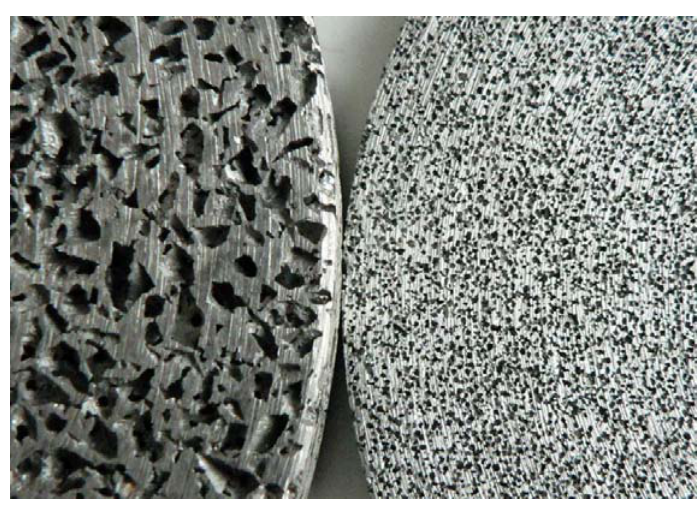
Figure 7. Micrograph of real foam